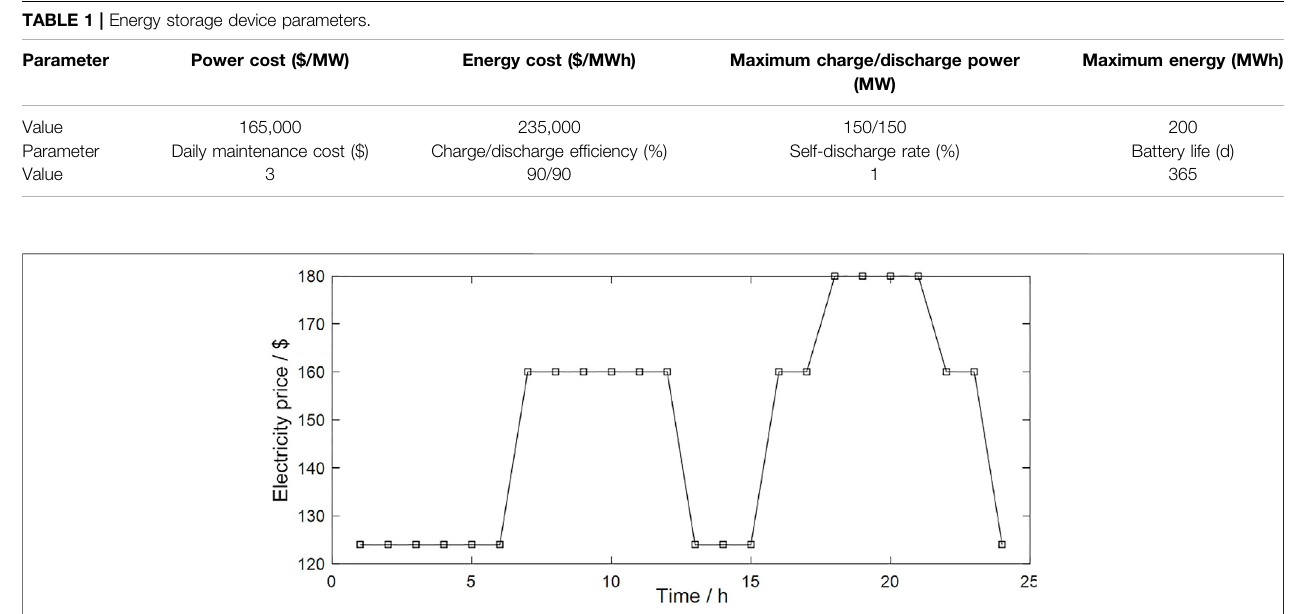
FIGURE 3 | Day-ahead transaction price between microgrid and power